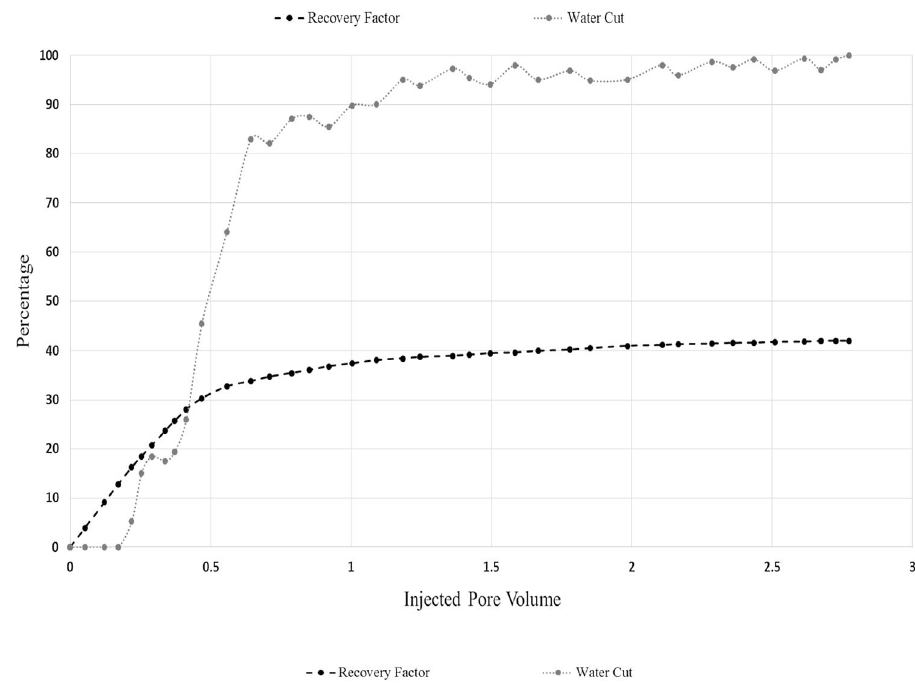
Fig. 5 Cumulative oil recovery and water cut during SW injec- tion and subsequent injection of emulsion 90/10 (test